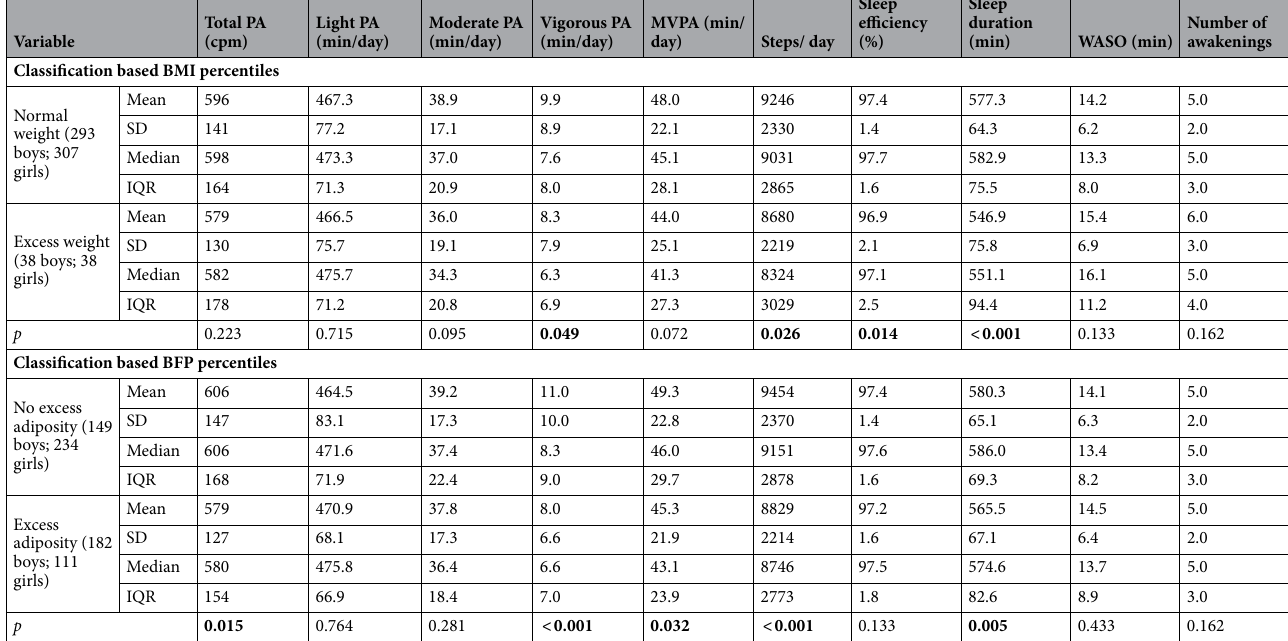
Table 2. Physical activity and sleep parameters among children with different body weight and adiposity levels based on the 85th percentile. BFP body fat percentage, BMI body mass index, MVPA moderate to vigorous